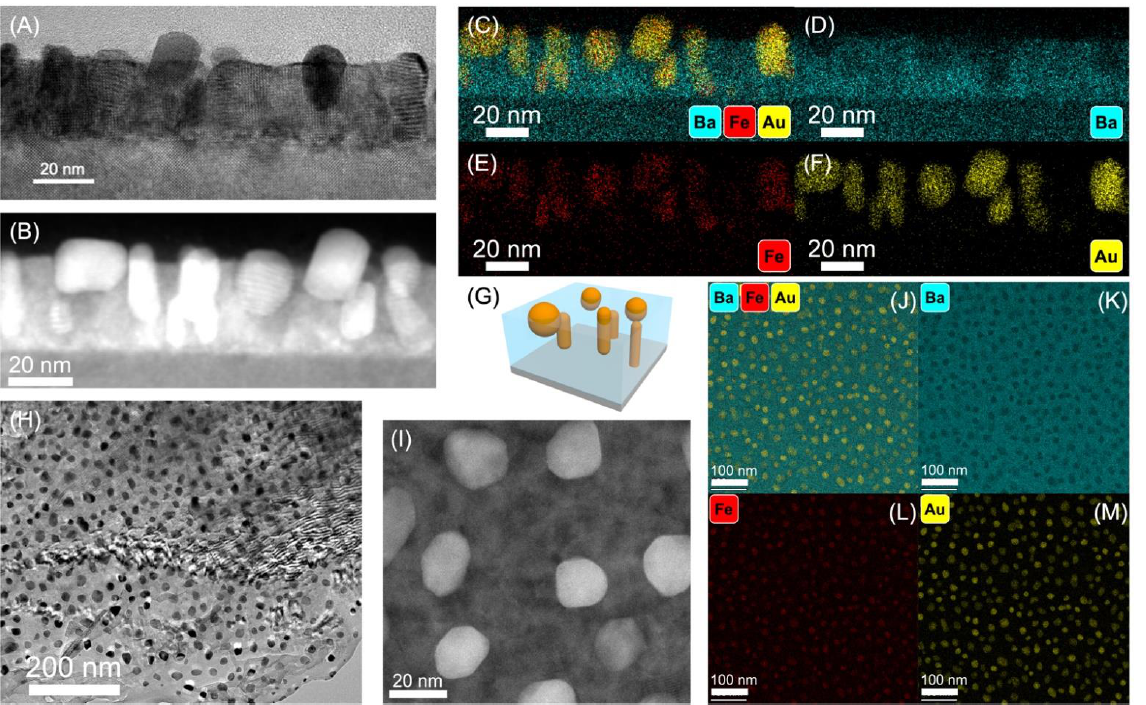
Figure 3. TEM results of 5 Hz sample: ( A ) cross-section TEM image, ( B ) cross-section STEM image, ( C ) cross-section EDX composite of Ba, Fe, and Au, ( D ) cross-section EDX of Ba, ( E ) cross-section EDX of Fe, ( F ) cross-section EDX of Au, ( G ) 3D schematic of 5 Hz sample, ( H ) plan-view TEM image, ( I ) plan-view STEM image, ( J ) plan-view EDX composite of Ba, Fe, and Au, ( K ), EDX composite of Ba, ( L ) EDX composite of Fe, ( M ) and EDX composite of Au.